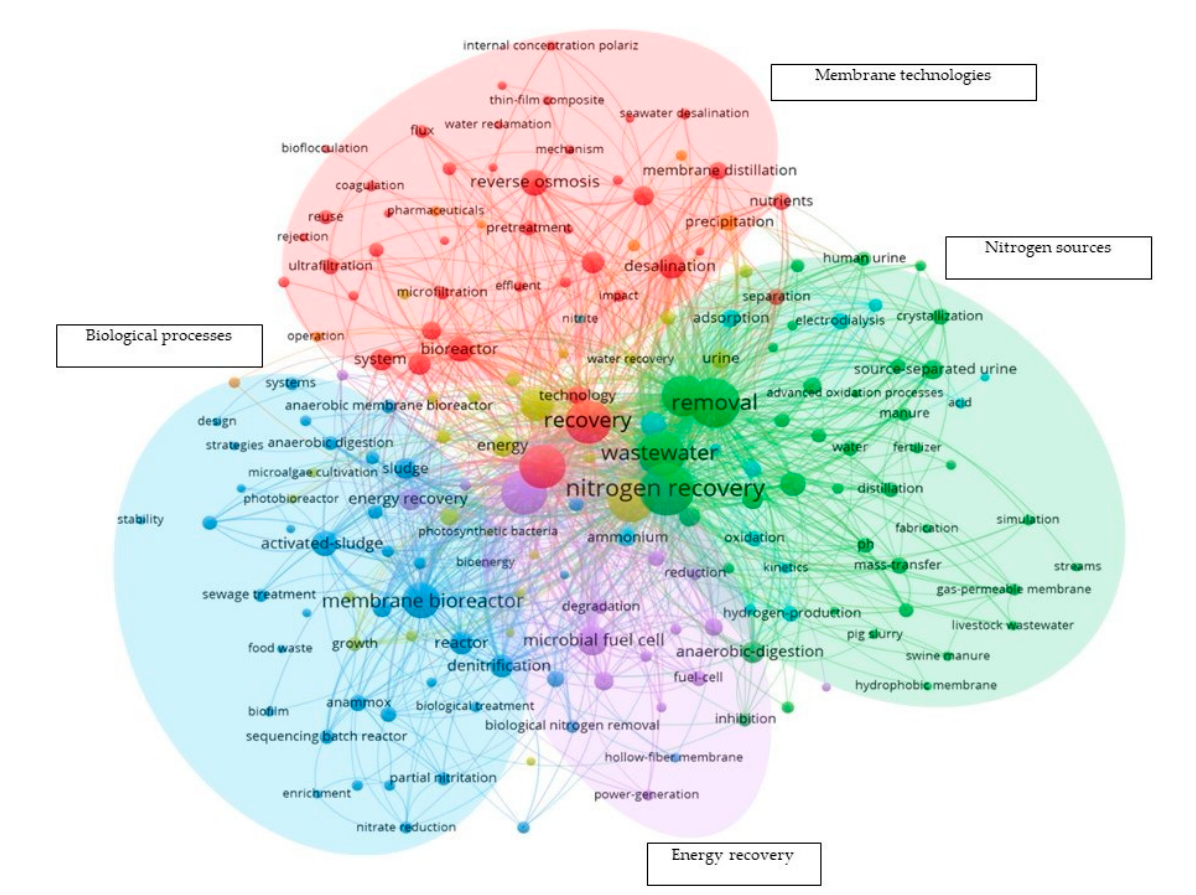
Figure 3. Keywords co-occurrence